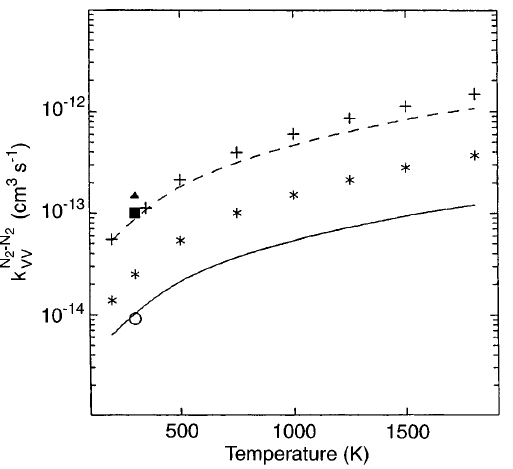
Fig. 3. The temperature dependence of the rate coe(cid:129)cient for the process